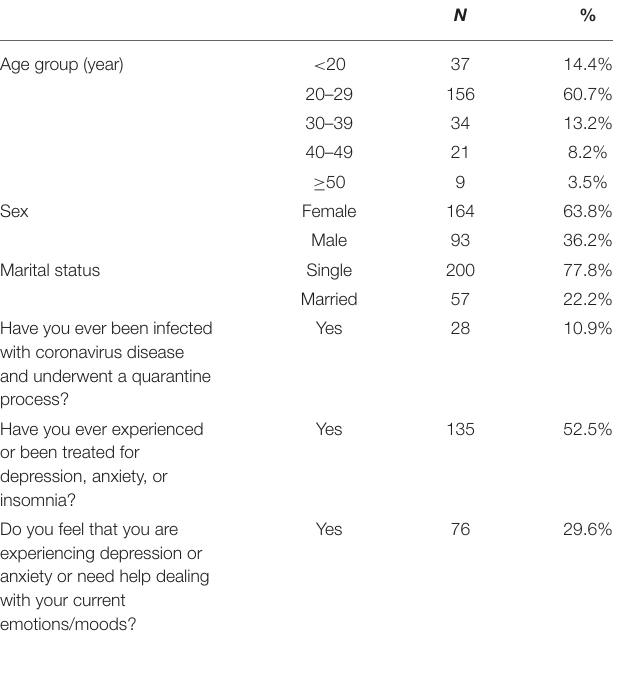
Malay version. Scale information curve shows that the SAVE-6 Malay version efficient to assess the latent trait between −